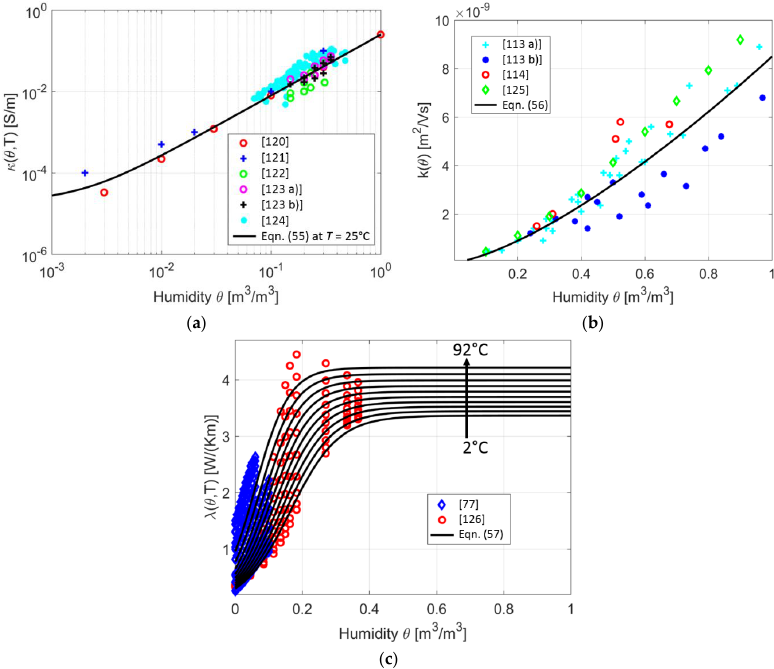
Figure 23. ( a ) Measurements of the electric conductivity of soil and fit by (55) at a temperature of 25 °C; ( b ) measurements of the electro-osmotic conductivity of soil and fit by (56); ( c ) measurements of the thermal conductivity of soil and fit by (57) [77,113,114,120 – 124,126 – 128].